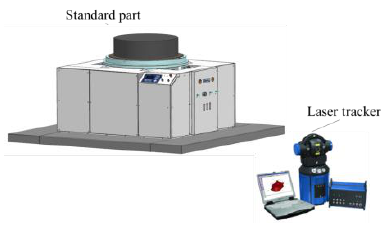
Figure 19. Standard sample mass centroid measurement diagram.